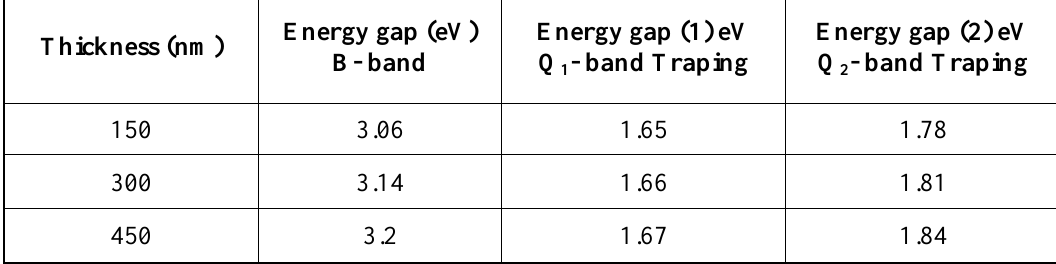
Table 2: Thin film thickness effect on optical energy gap for CuPc thin films.